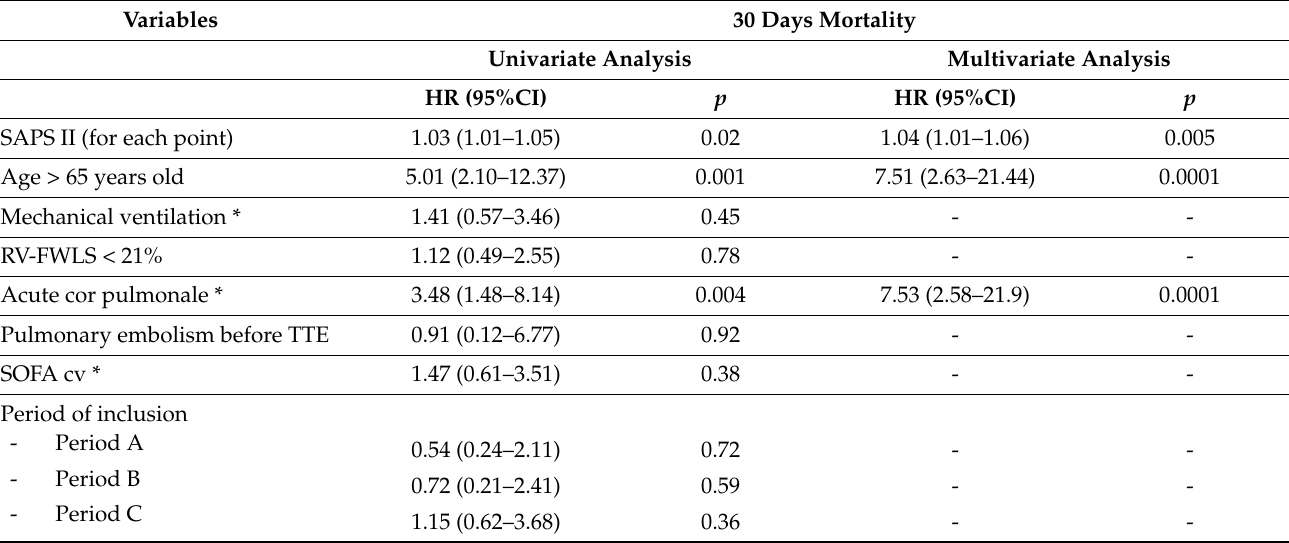
Table 3. Univariate and multivariate Cox analysis of variables associated with 30-day mortality.